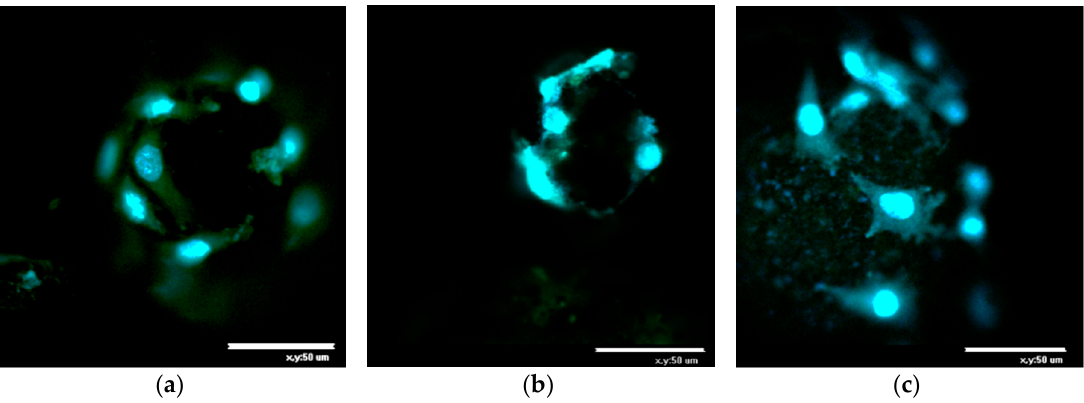
Figure 7. Confocal microphotographies of L929 fibroblasts after 3 days of culture on ( a ) control PDLA, 30 wt. % ( b ) CPLG- and ( c ) CPG-contained microparticles. Scale bar is 50 μ m. Living cells were stained with vital fluorescent dye Calcein AM and cell nuclei were stained with DAPI.